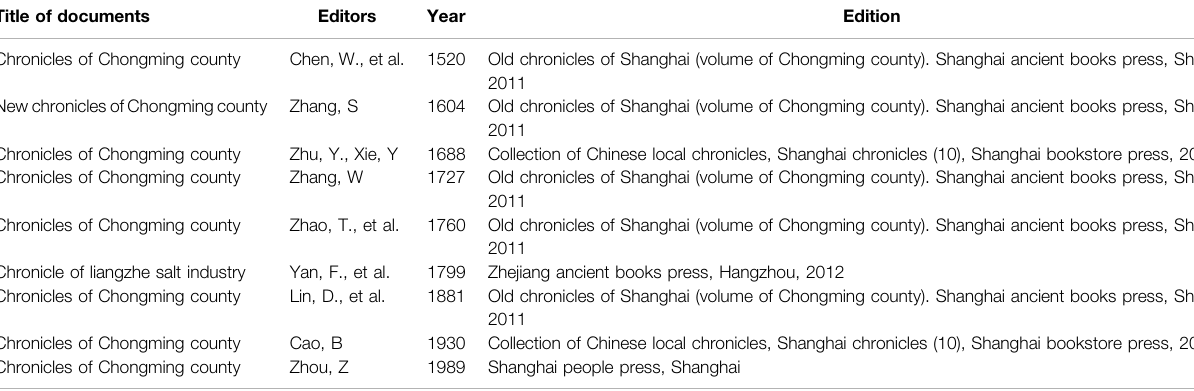
TABLE A1 | The relative historical documents in wetland development data of the Chongming Island.